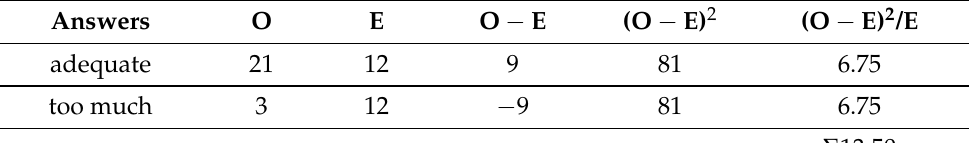
Table 4. Responses for the question Sensing DCBLP